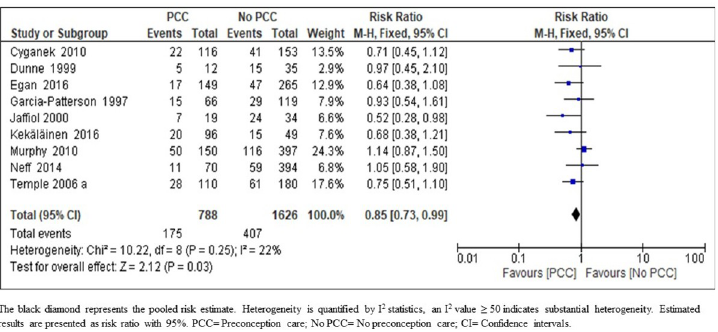
Fig 6. Risk ratio for preterm delivery from nine studies of women with pre-existing diabetes mellitus who did or did not receive preconception